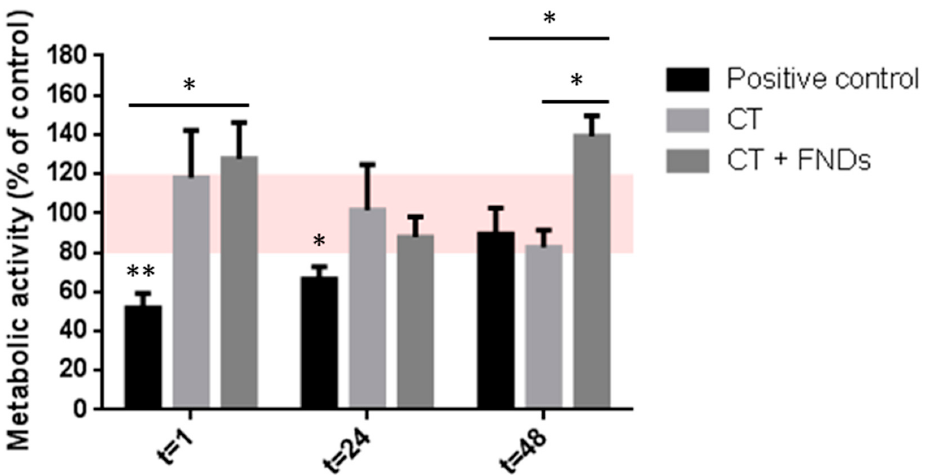
Figure 1. Metabolic activity of cells after uptake protocol and/or addition of FNDs. In the positive control, cells were incubated in boiling water for 20 minutes; the CT sample has been subjected to the chemical transformation only; and the CT + FND sample has been subjected to both the chemical transformation and the FNDs. The activity is given as a percentage of the negative control; the viability between 80% and 120% (red area) is considered to be unaffected. Error bars show the standard error of the mean. Significance is tested against the negative control (* p < 0.05, ** p < 0.01).